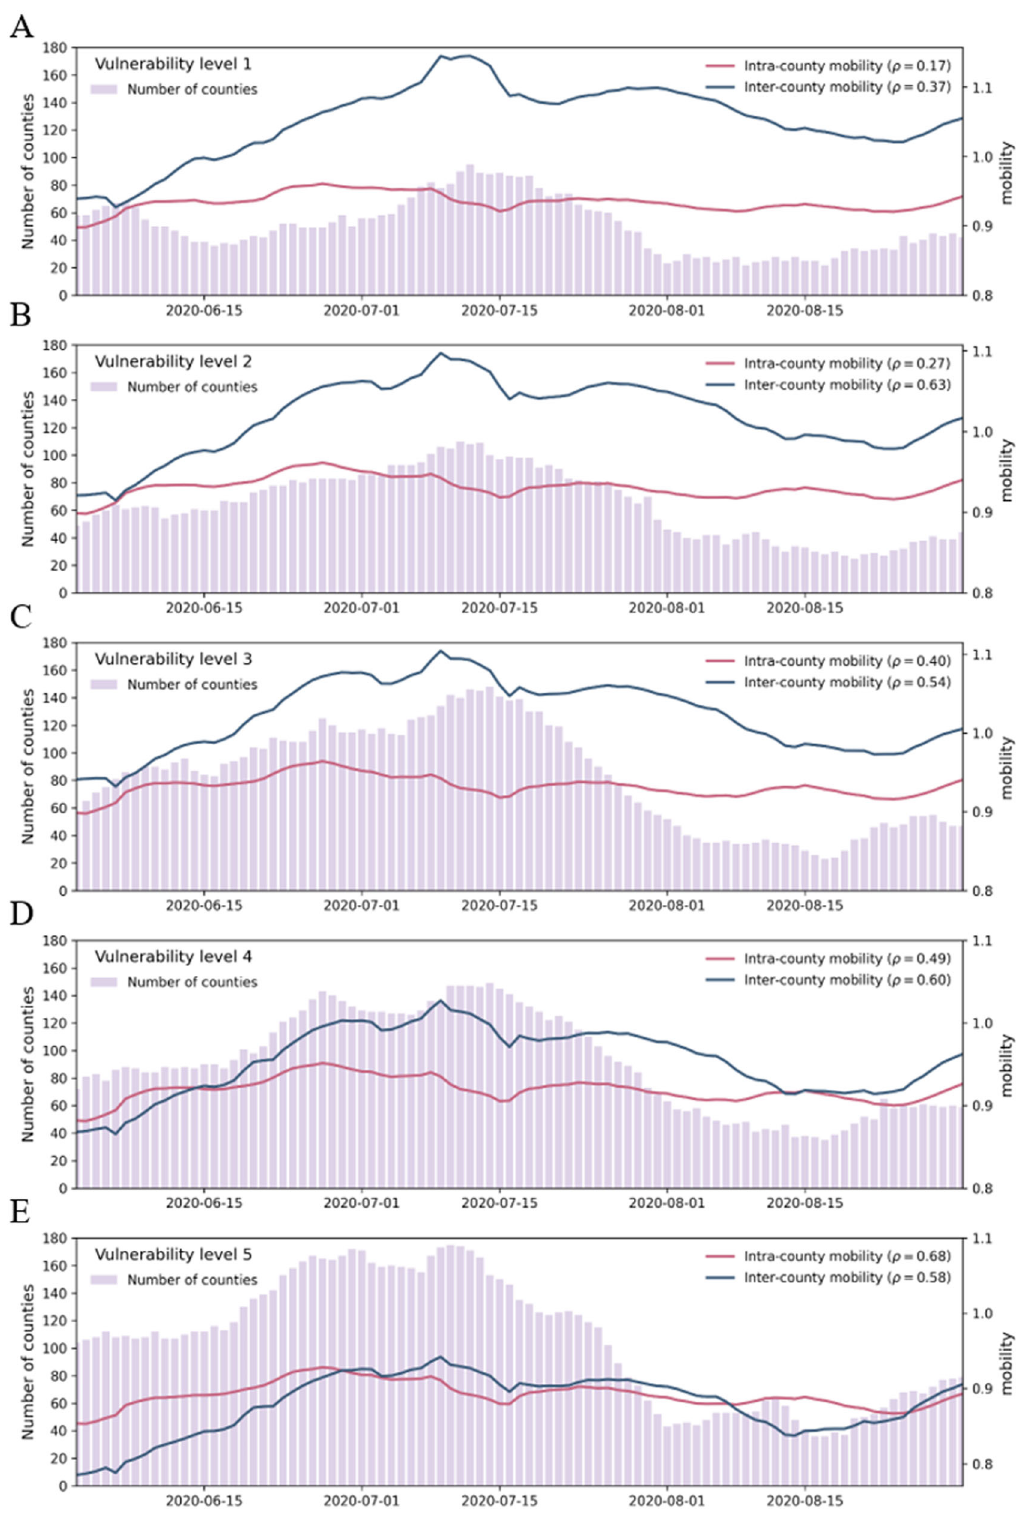
Fig. 5 The average mobility and number of counties per day with a daily R t ≥ 1 (i.e., counties with high transmissibility) across varying vulnerability levels from June 1 to August 31. A – E vulnerability levels 1 – 5. Mobility includes both IntraM and InterM. All mobility values are the average of each level and smoothed using a 7-day moving average. All Pearson correlation coef fi cients between mobility and the number of counties with high transmissibility are statistically signi fi cant ( p <